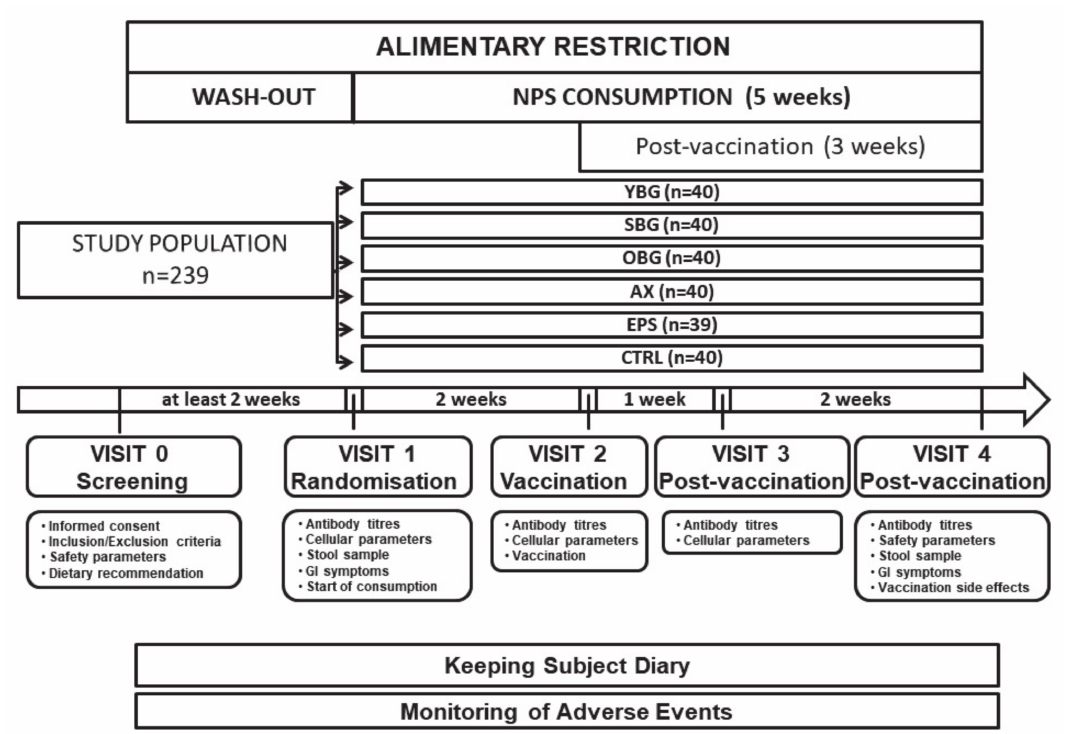
Figure 1. Design of the pilot study ( n = 239). A screening visit (visit 0) was conducted at least two weeks prior to randomisation (visit 1). After randomisation, subjects started consuming NPS or CTRL product daily for five weeks. After two weeks consumption, subjects were vaccinated against influenza (visit 2). Follow-up visits were conducted one week (visit 3) and three weeks (visit 4) post-vaccination. Black boxes indicate parameters that were measured at each visit. Subjects kept a diary assessing compliance and respiratory symptoms and followed a low dietary fibre diet for the complete duration of the study. Adverse events were monitored by investigators throughout the study. NPS: non-digestible polysaccharide, YBG: yeast β -glucan, SBG: shiitake β -glucan, OBG: oat β -glucan, AX: arabinoxylan, EPS: exopolysaccharide, CTRL: control (maltodextrin), GI: